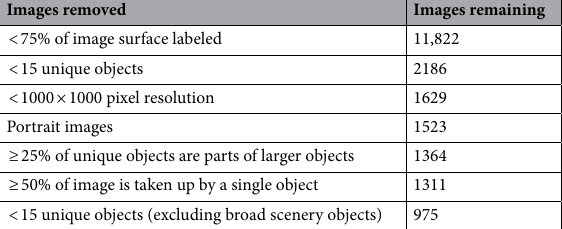
Images removed Images